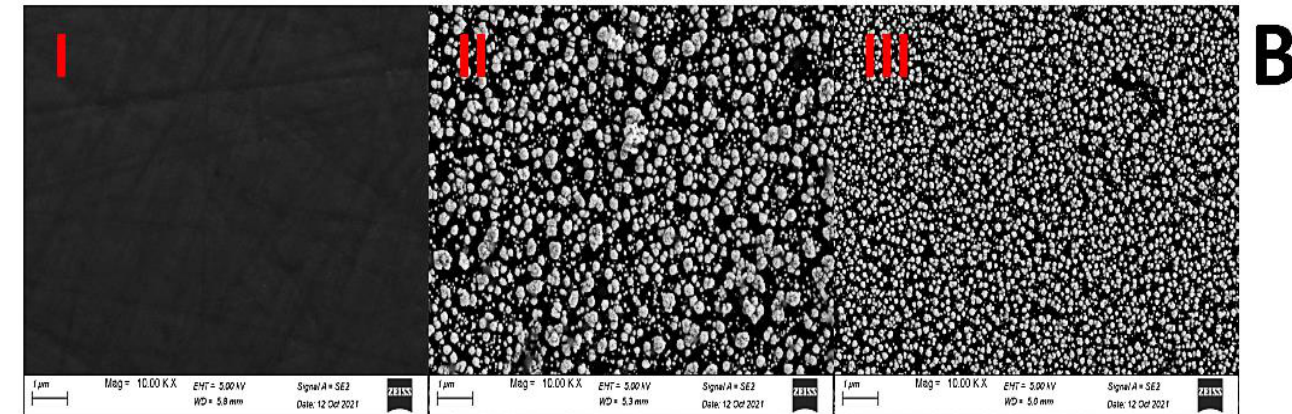
Figure 3. ( A ) AFM image of bare GCE ( I ), AuNPs-GCE ( II ) and poly ( DL -met)/AuNPs-GCE ( III ). ( B ) SEM images of bare GCE ( I ), AuNPs-GCE ( II ) and poly ( DL -met)/AuNPs-GCE ( III ).